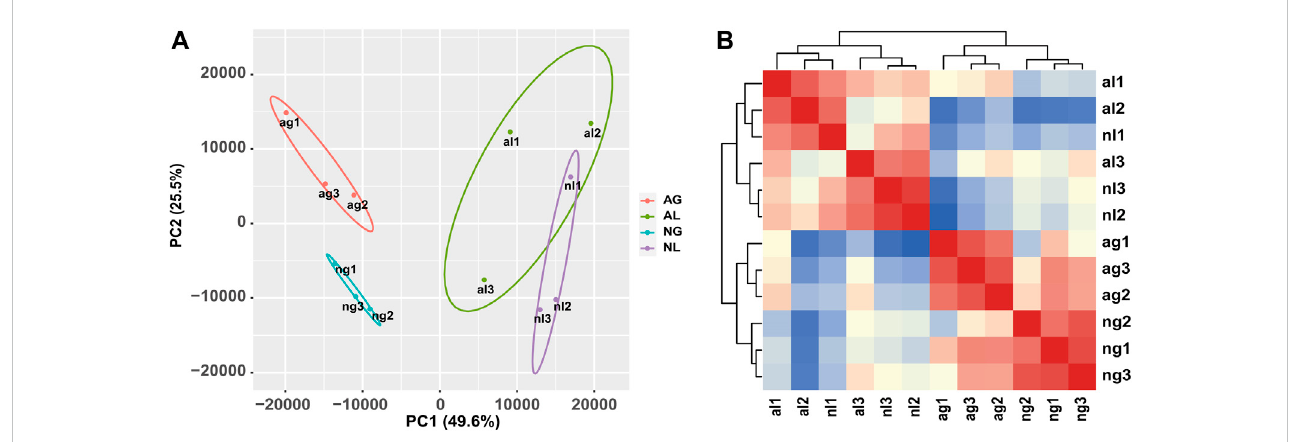
FIGURE 1 Analysis of African lung fi sh samples during aestivation. (A) Heat map of cross-correlations of all samples with differentially expressed transcripts. (B) Cluster diagram of principal component analysis for all samples. ag: aestivating gills; ng: non-aestivating gills; al: aestivating lungs; nl: no-aestivating